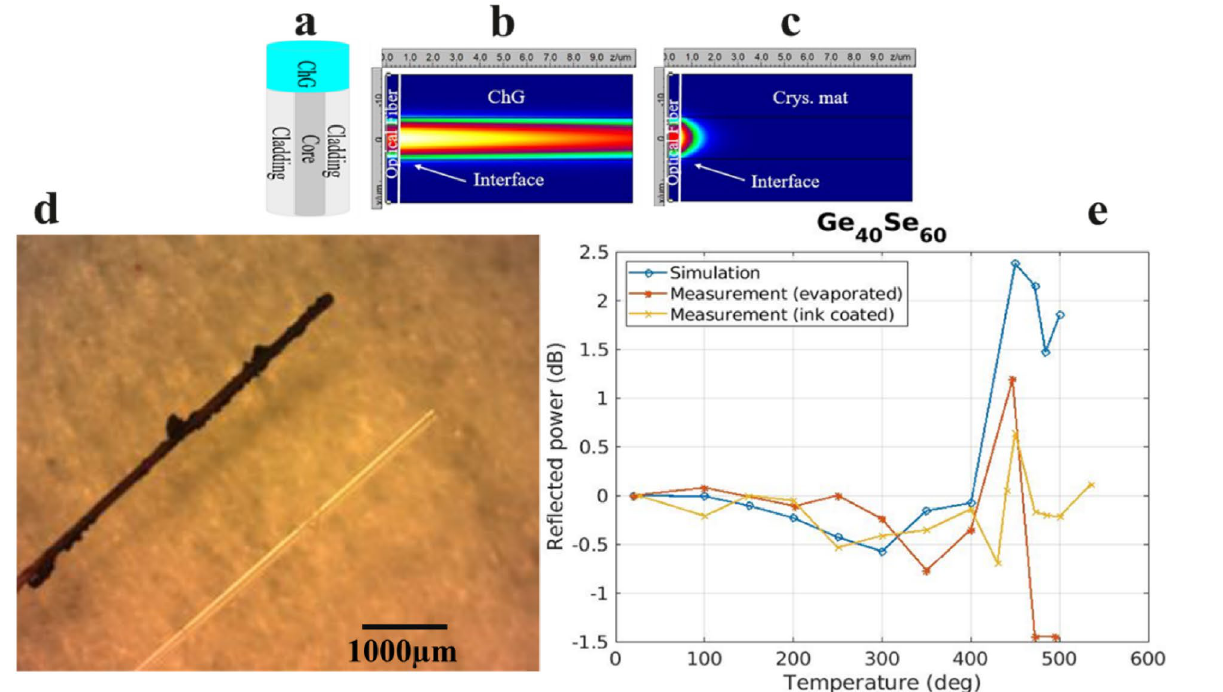
Figure 9. ( a ) Cross-section of ChG-capped optical fiber tip-based temperature sensor; ( b ) power distribution at the fiber-Ge 40 Se 60 interface in the amorphous phase, ( c ) power distribution at the fiber-Ge 40 Se 60 interface in a crystalline phase, ( d ) dip coated fiber tip (dark) and blank fiber tip (transparent), ( e ) comparison of sensor performance. ( b , c ) Results of simulation done in PhotonDesign (FIMMWAVE, FIMMPROP version 6.6.2) software (http:// www. photo nd. com/ index.